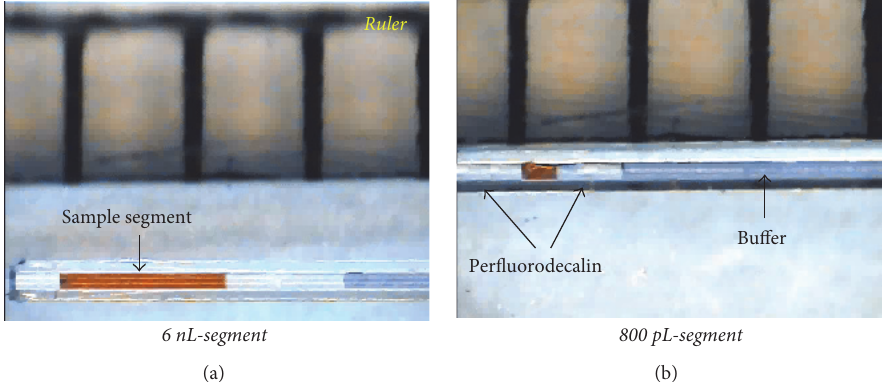
Figure 2: (a) CCD image of a sample segment (red-color) in between perfluorodecalin plugs. The loaded volume was calculated to be ∼ 6nL. A buffer solution was mixed with blue-ink for clearer demonstration. (b) CCD image of a sample segment (red-color) with the loaded volume of 800